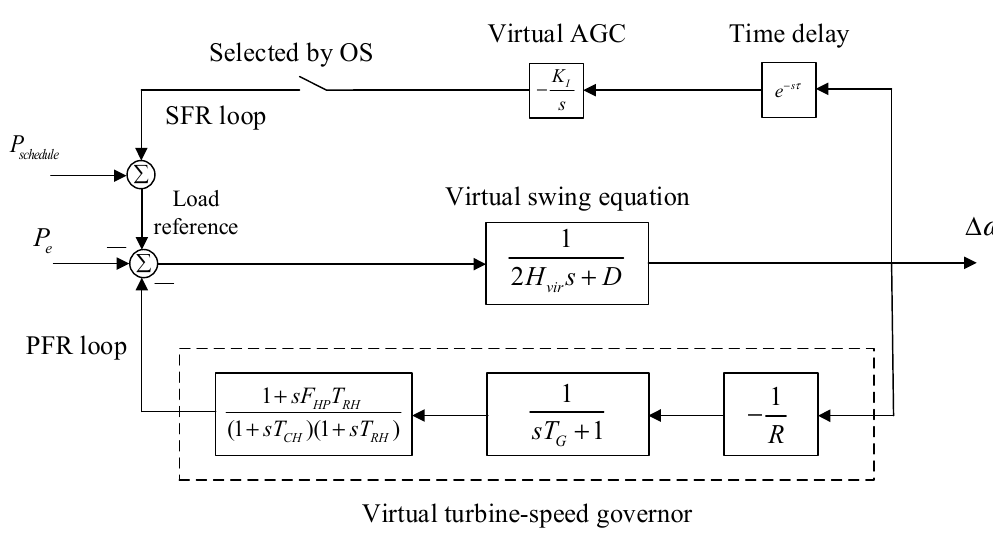
Figure 3. Implementation of TFR.